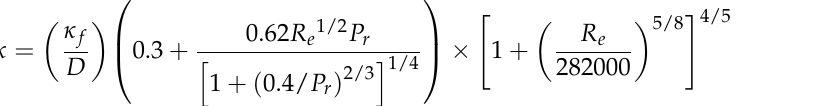
Table 1. Physical properties of brush filament